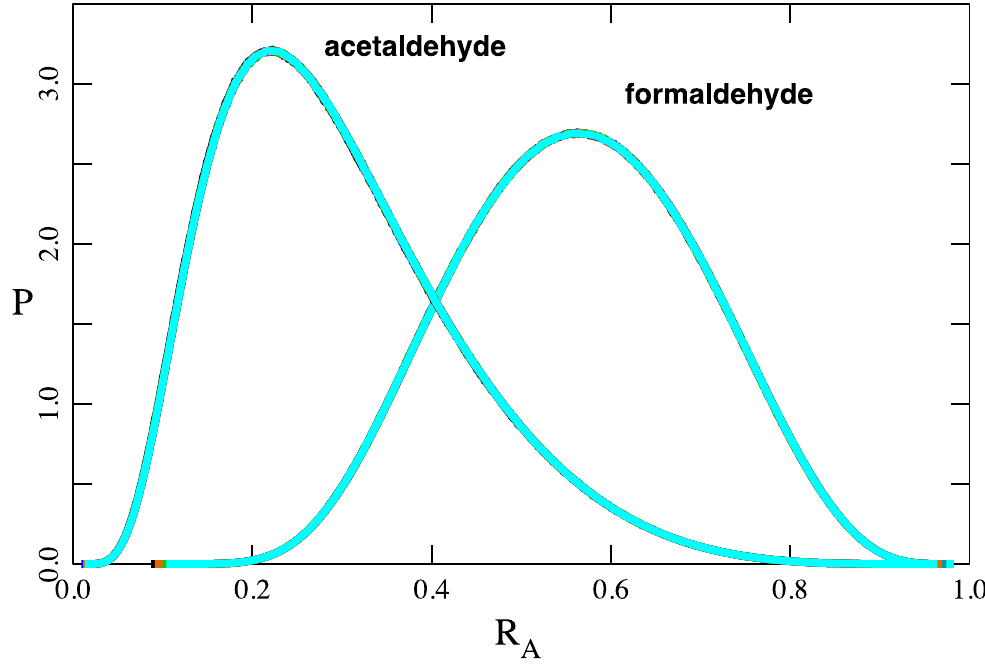
Figure 8. Distributions of R A when model parameters are selected according to Table 7. Individual curves for k 21A between 10 − 6 s − 1 and 10 − 2.5 s − 1 have all been drawn but lie on top of each other at the resolution of the figure.